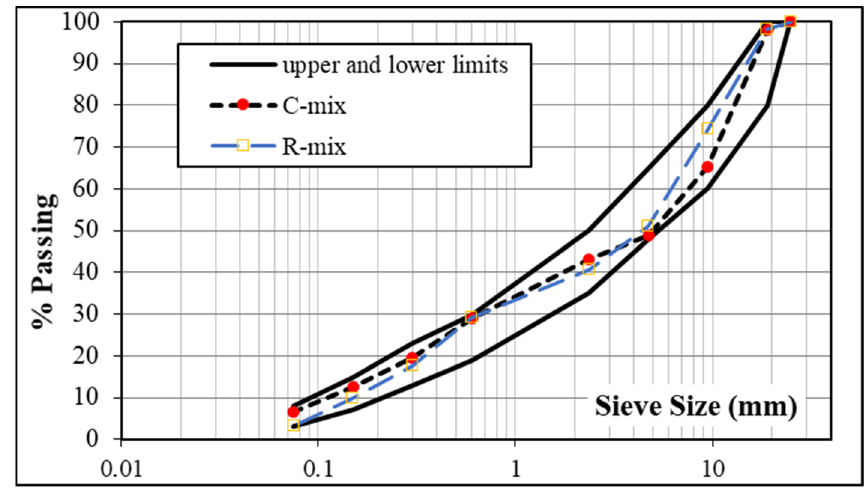
Figure 12. Designed gradation of recycled mix. Table 6. Summary of Marshall parameters and volumetric properties of the investigated mixes.